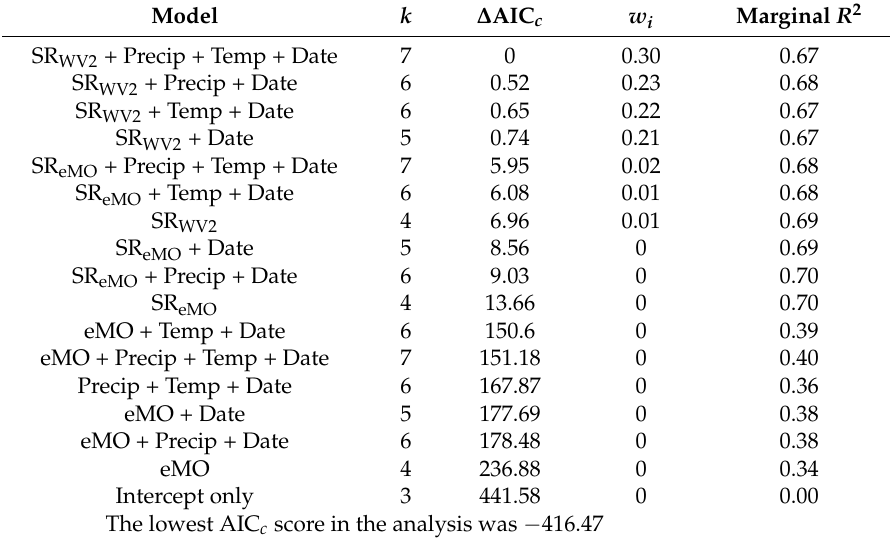
The lowest AIC c score in the analysis was − 416.47